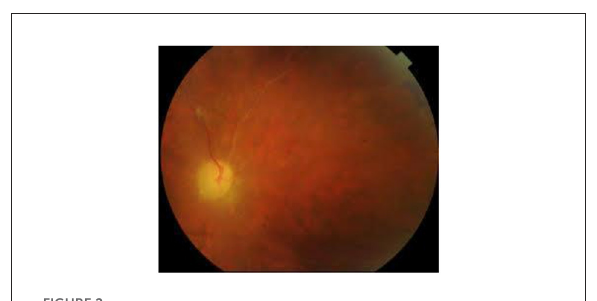
FIGURE2 Colored fundus photo of Behçet uveitis showing a pale disc and ghost vessels following the occlusive vasculitis (Image courtesy of Dr. Soliman MM,